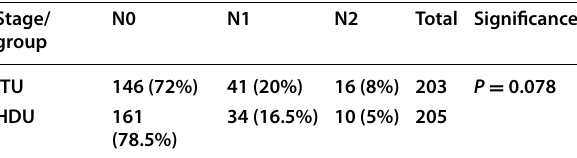
Total Significance